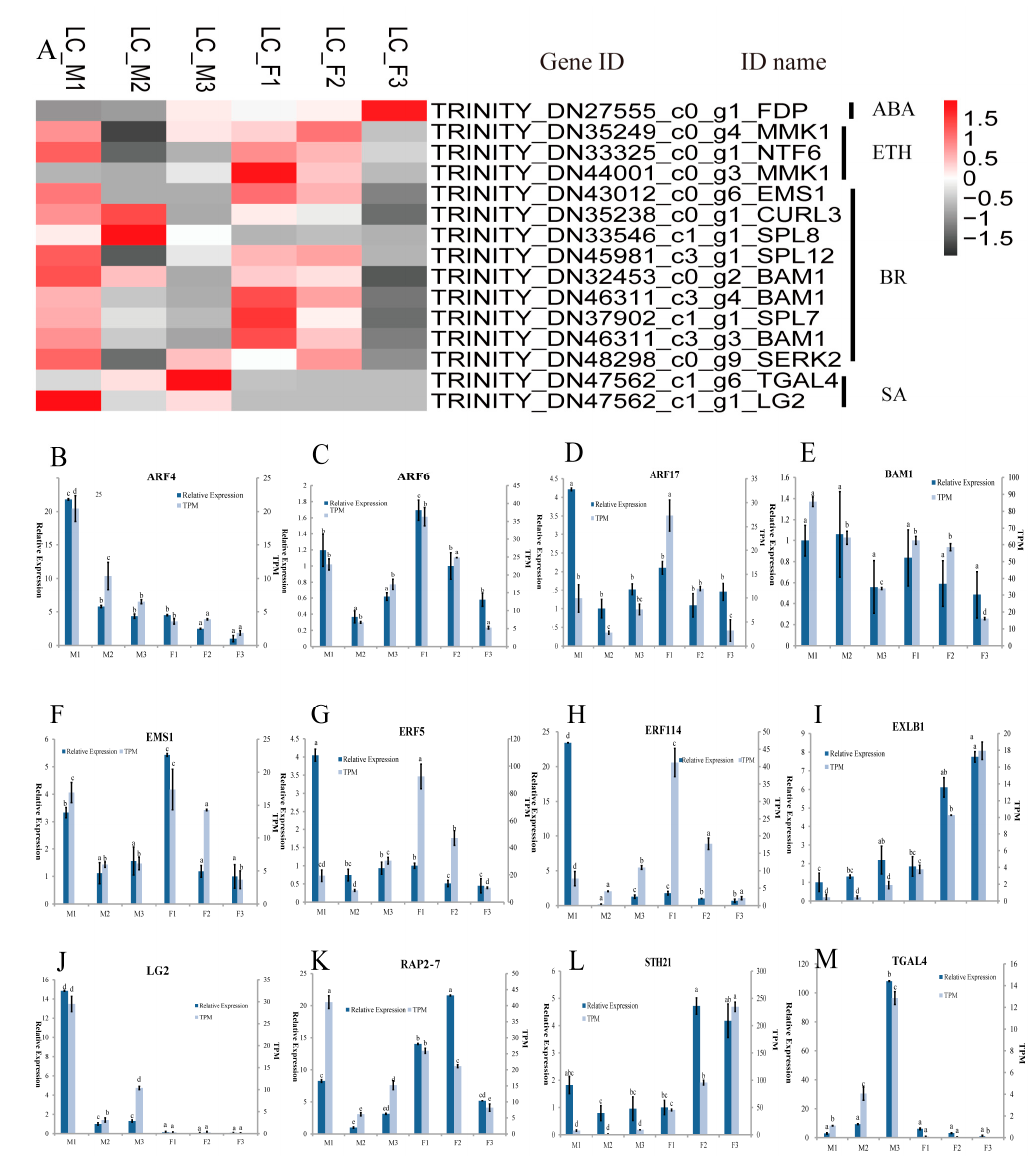
Figure 3. The expression pattern of candidate genes involved in the floral development in L. cubeba . ( A ) Heatmap analysis of key stamen developmental genes in male and female flower; ( B – M ) expression levels of ARF4 , ARF6 , ARF17 , BAM1 , EMS1 , ERF5 , ERF114 , EXLB1 , LG2 , RAP2-7 , STH21 and TGAL4 based on transcripts per million (TPM) and qRT-PCR data. Di ff erent letters represent significant di ff erence in mRNA levels ( p < 0.05). Error bars mean